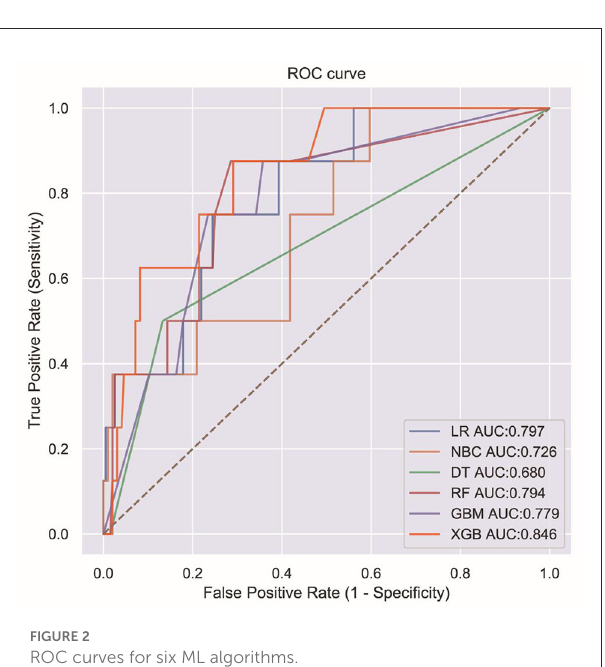
FIGURE2 ROC curves for six ML algorithms.